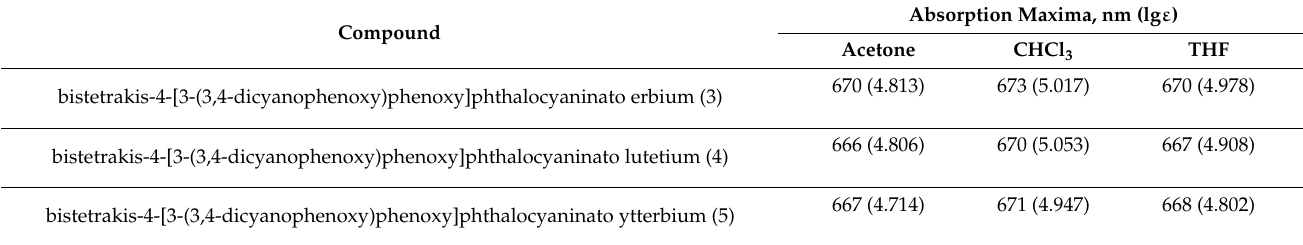
Table 1. Spectroscopic characteristic of rare-earth double-decker bistetrakis-4-[3-(3,4-dicyanophenoxy)phenoxy]phthalocyan ine complexes in organic